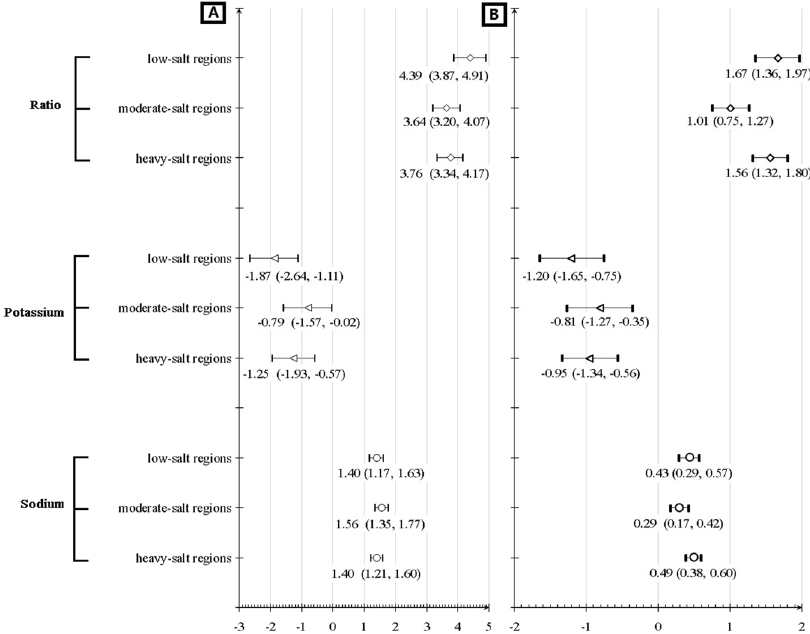
Figure 4. Changes of systolic ( A ) and diastolic ( B ) blood pressure per one unit increase of 24-hour urinary sodium excretions, 24-hour urinary potassium excretions, and their ratio for sodium vs. potassium by various salt-diet